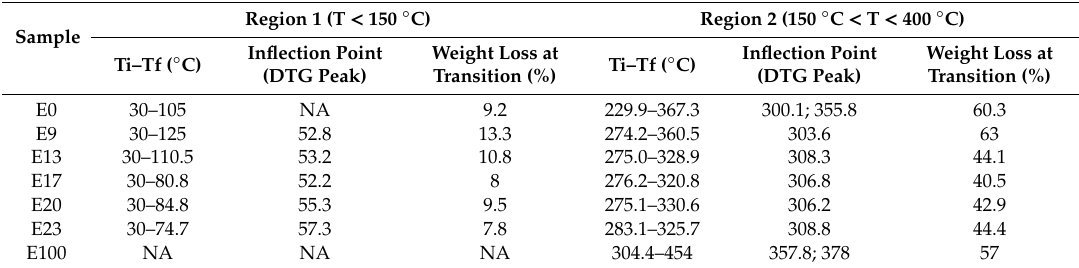
Table 2. Mass reduction and Peak points from TG curves. Table 3. Water content of sago fiber-epoxy composite.